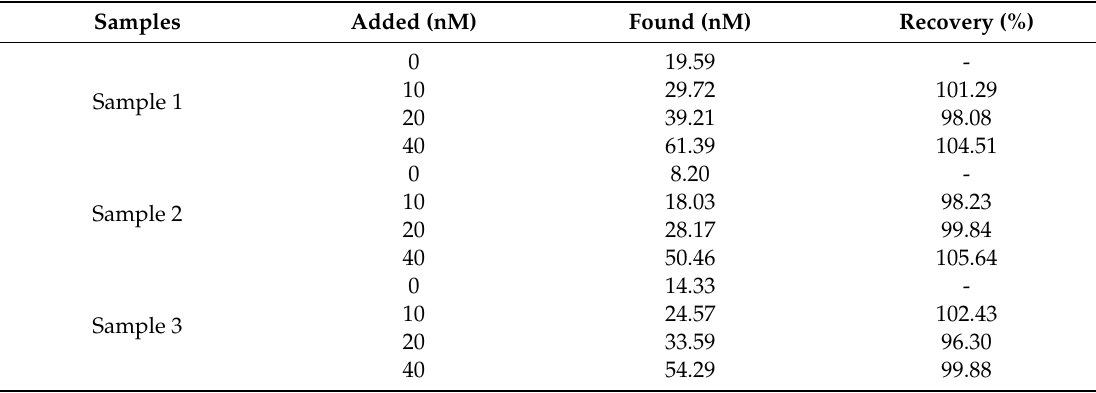
Table 1. Determined results of salivary cortisol from three subjects and recoveries of samples spiked with di ff erent concentration of cortisol using the smartphone-controlled DPV